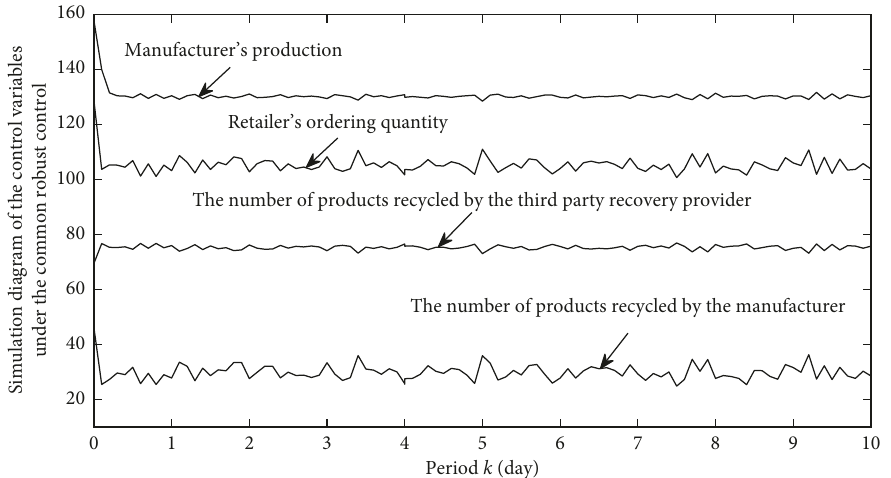
Figure 4: Simulation diagram of the control variables under CRC (unit: × 10 3